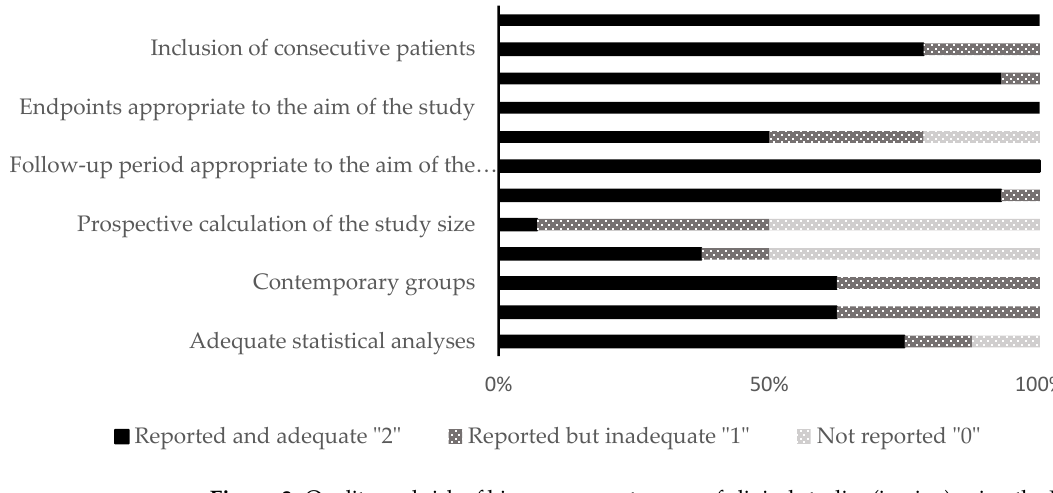
Figure 3. Quality and risk of bias assessment scores of clinical studies (in vivo) using the MINORS tool.